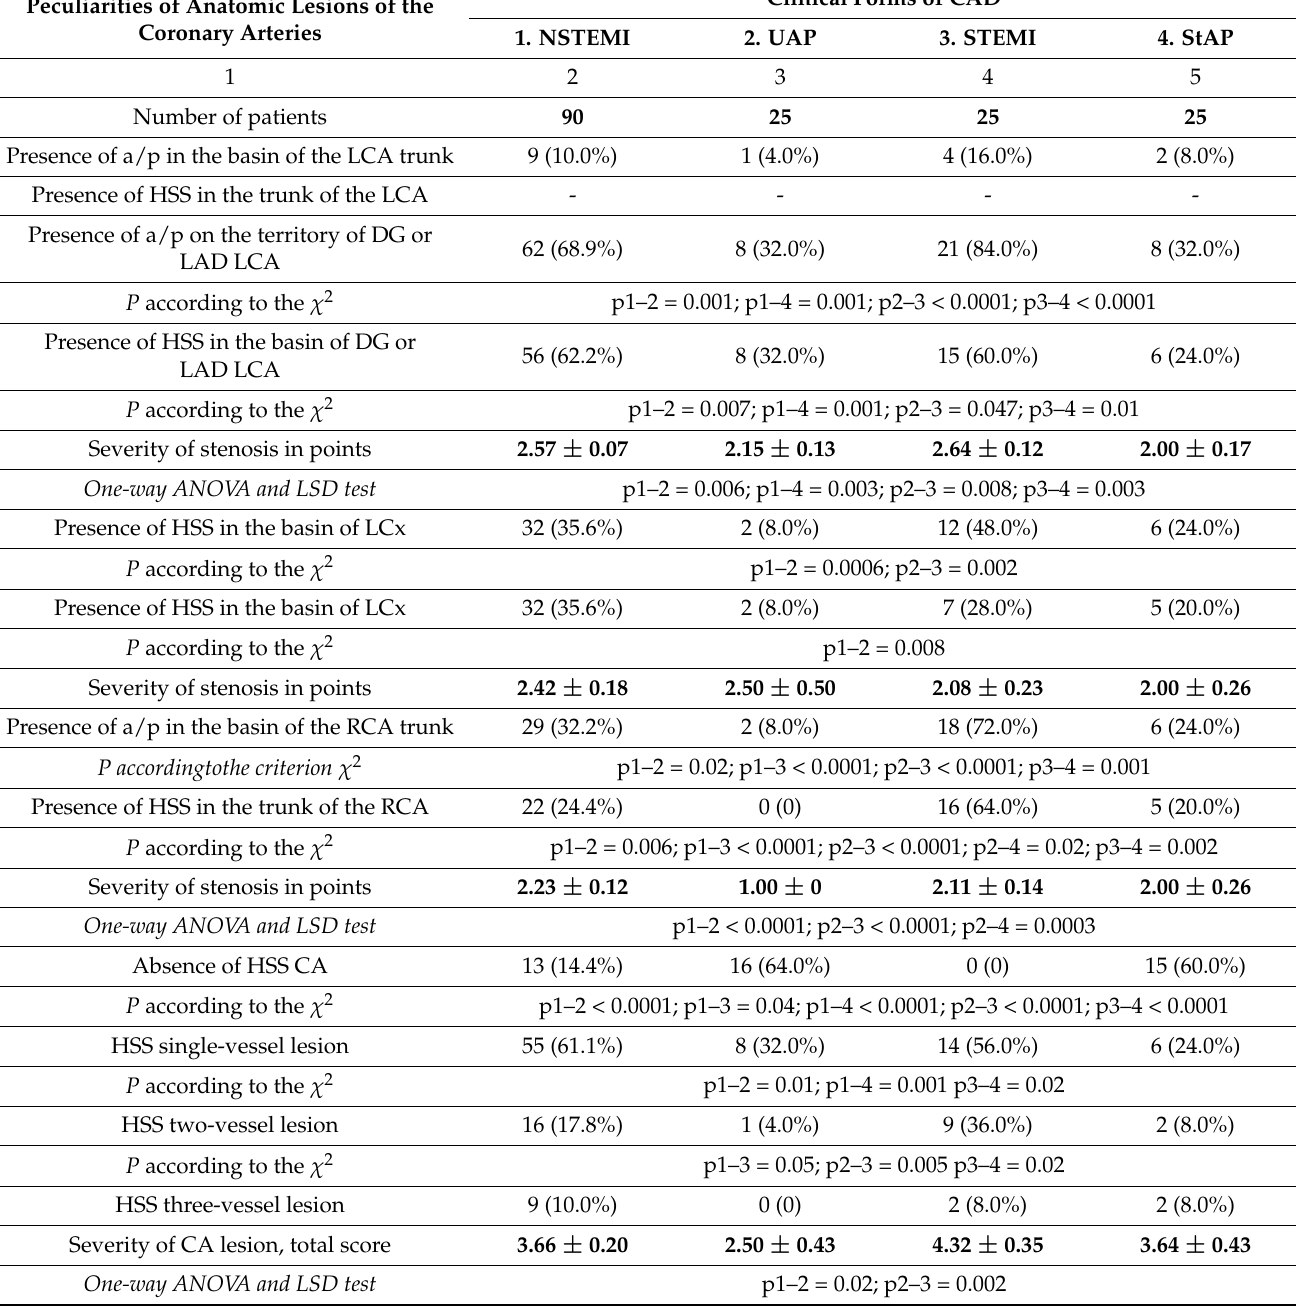
Table 1. Statistics of anatomical lesions of the coronary arteries in patients with various forms of